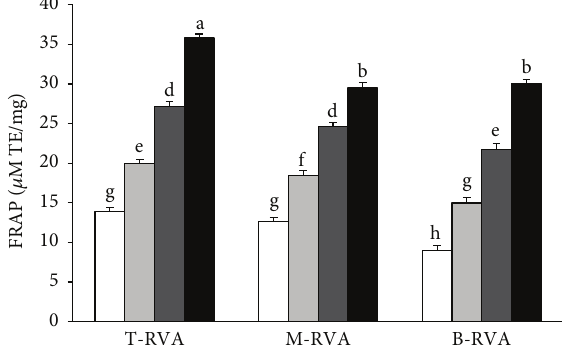
Figure 5: The effect of RVA on FRAP assay. a – g Values not sharing a common letter are significantly different at 𝑃 < 0.05 by Dunnett’s multiple range tests. Light gray square, 125 𝜇 g/mL; gray square, 250 𝜇 g/mL;darkgreysquare,500 𝜇 g/mL;blacksquare,1,000 𝜇 g/mL.